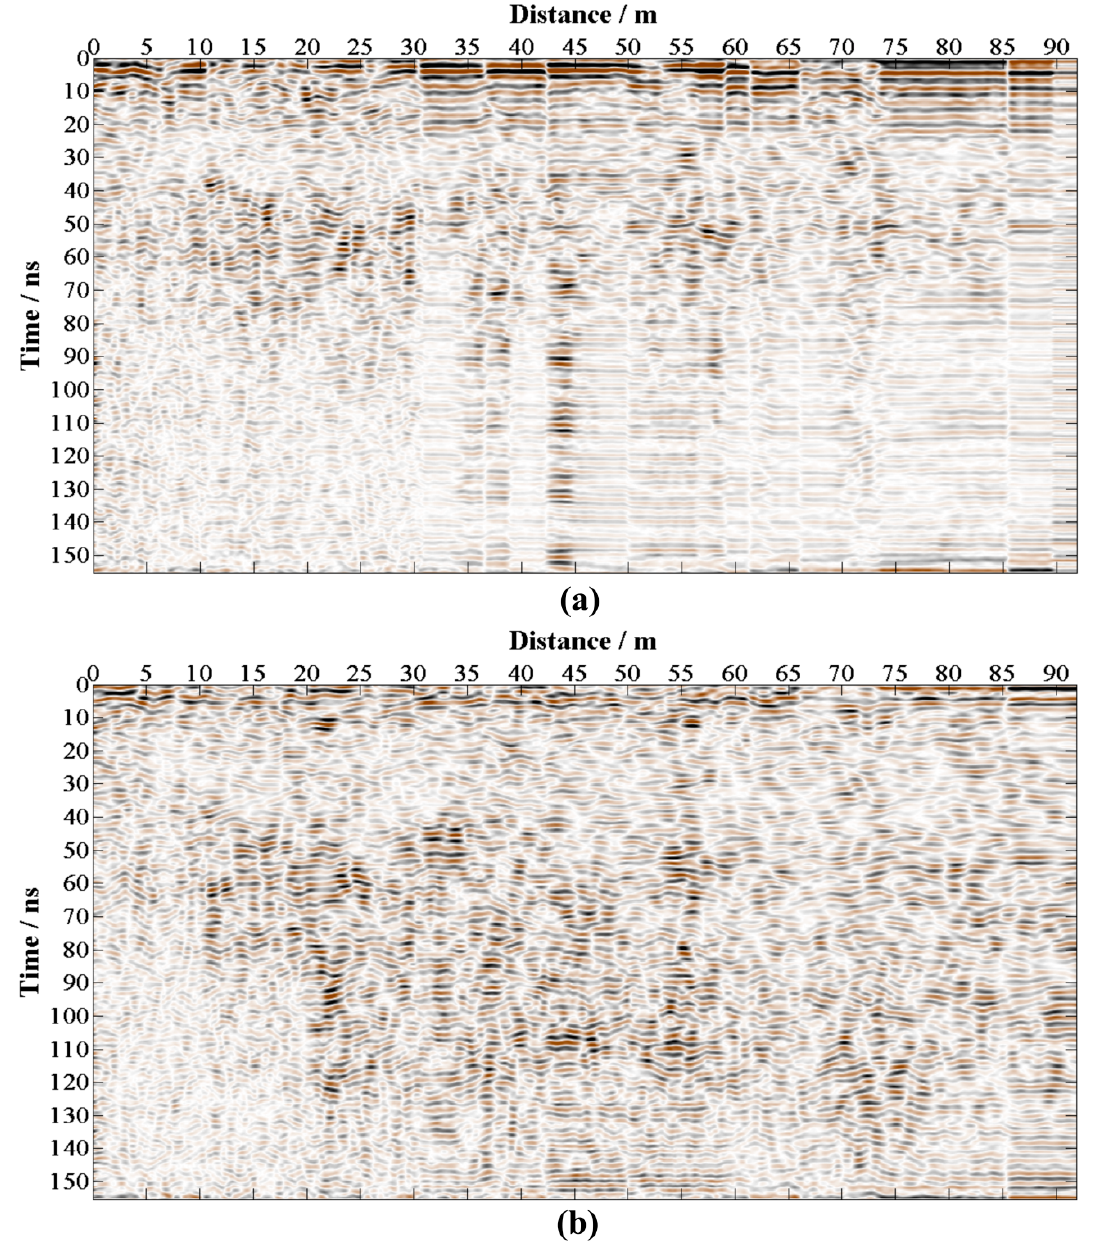
Figure 10. The results of the dip filter for ( a ) LPR CH-2A data and ( b ) LPR CH-2B data.